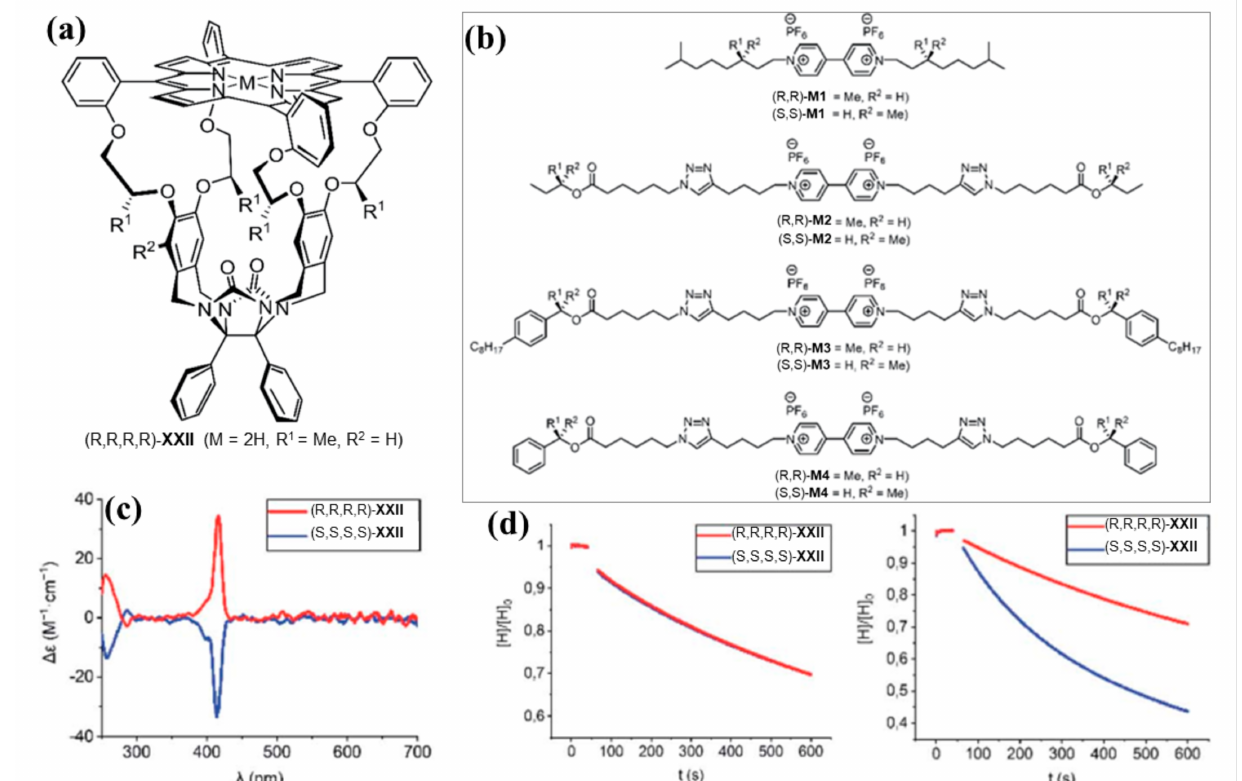
Figure 19. ( a ) Molecular s tructure of the chiral macrocyclic porphyrin XXII ; ( b ) Chemical structures of viologen molecules. ( c ) CD spectra of enantiomers (R, R, R, R)- and (S, S, S, S)- XXII in chloroform-acetonitrile 1:1 ( v / v ) mixed solvent; ( d ) Normalized fluorescence intensity of enantiomers (R, R, R, R)- and (S, S, S, S)- XXII as a function of time after the addition of 1 equivalent of (R, R)- M3 (on the left) and (R, R)- M4 (on the right). Adapted from reference [82] under Creative Commons Attribution 3.0 Unported License; published by Royal Society of Chemistry